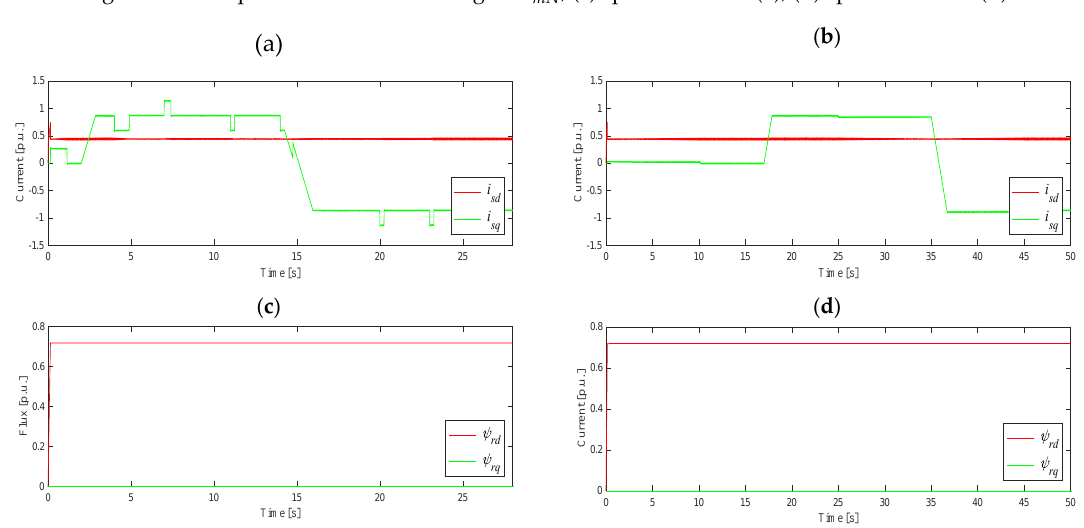
Figure 4. Reference and measured angular speed waveforms: ( a ) for various speed set points, ( b ) during slow start-up and reverse in the range ± ω mN , ( c ) speed error for ( a ), ( d ) speed error for ( b ).